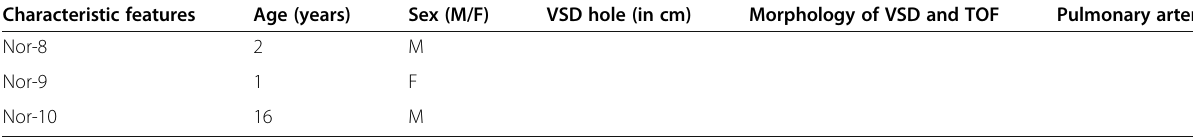
Table 1 Details of clinical and diagnostic analysis for TOF and VSD samples used for whole-exome sequencing (*) and validation (without asterisk) (Continued)